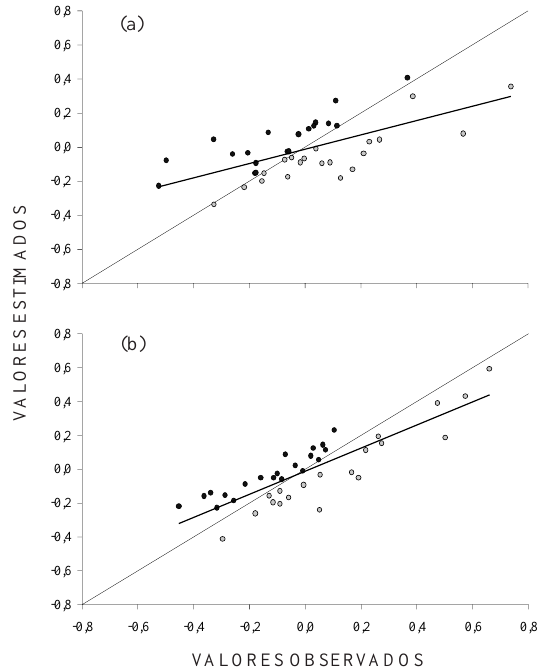
Figura 6. Valores observados vs estimados para os resíduos da regressão linear do logaritmo da taxa de infiltração após 3,5 min (a) e 105 min (b), com a reta ajustada e a reta 1:1.